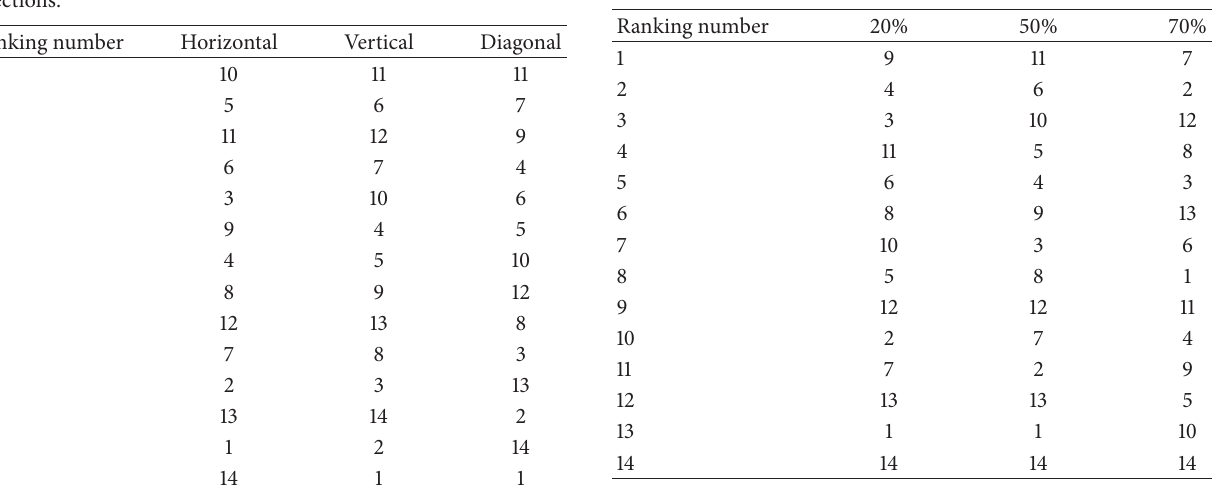
Table 7: Performance ranking of cipher text image by descending order in Figure 3 with different upper bound value gap